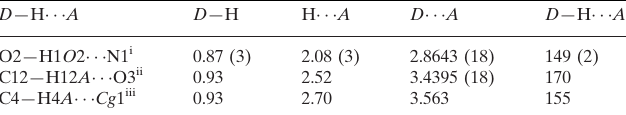
Hydrogen-bond geometry (A˚ , (cid:2) ). Cg 1 is the centroid of the thiazole